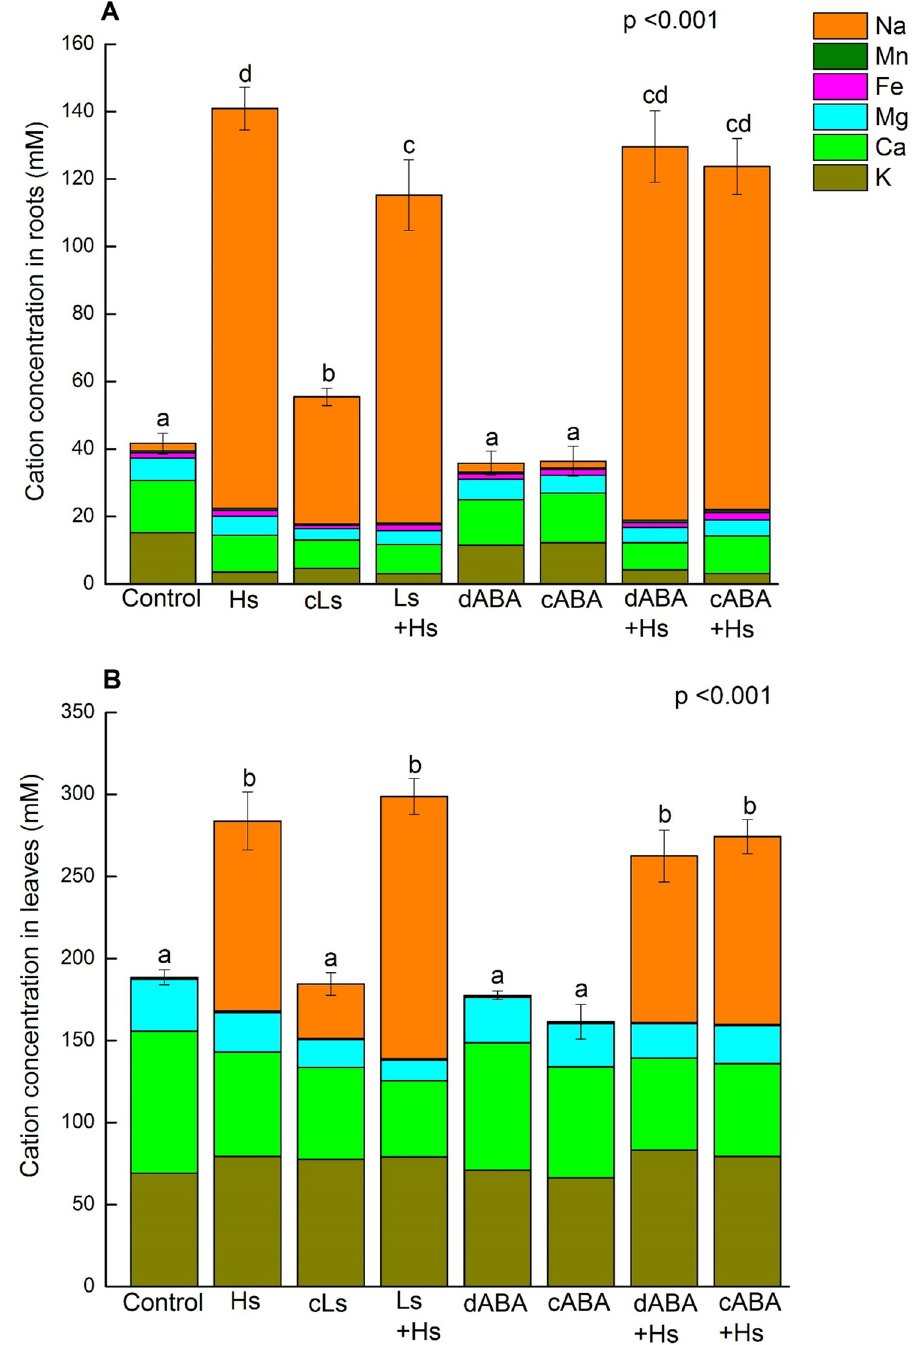
Fig 3. Concentration of cations in the root (A) and leaf tissues (B) of P . × canescens plants in response to salinity and ABA. Cations (mM) were calculated as sum of K + , Ca 2+ , Mg 2+ , Fe 2+ , Mn 2+ and Na + . Bar represents means ± SE (n = 5 or 10). Average content of specific ion is presented by specific color on the bar. One-way ANOVA was conducted. Normal distribution of data was tested by plotting residuals and log transformation was used in case of cation content in root. Different letters obtained from Fisher’s test indicate significant differences among treatments at p < 0.05.